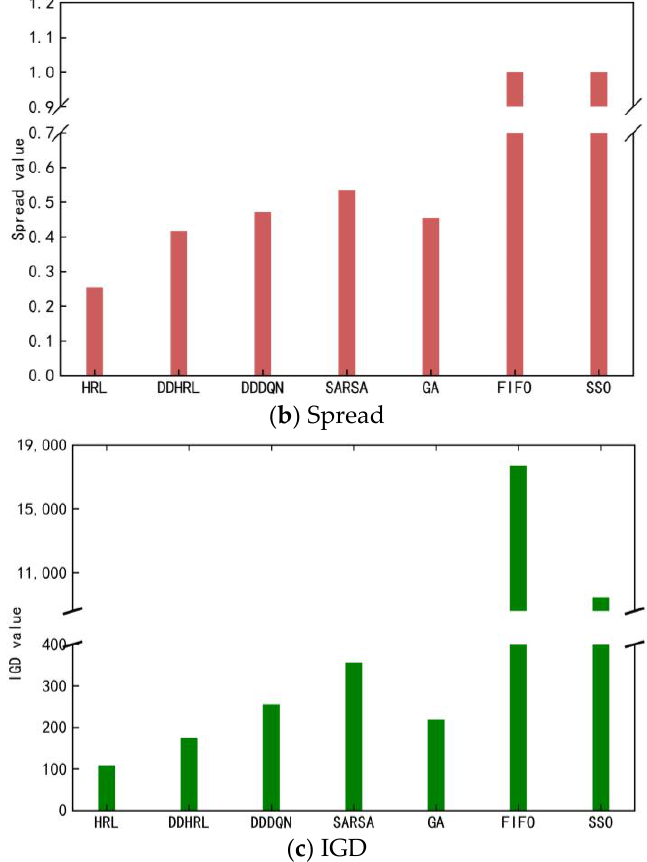
Figure 5. Average values of the algorithm metrics compared for all test instances.